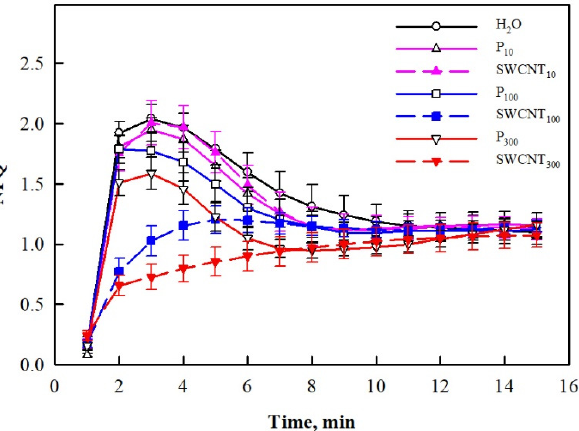
Figure 5. Time course of NPQ development during illumination of pea plants. Data were recorded seven days after spraying with different concentrations of “Pluronic” P-85 (P 10,100,300 ) and SWCNTs (SWCNT 10,100,300 ). Plants sprayed with H 2 O served as the control. Data are means ± SE ( n = 6).